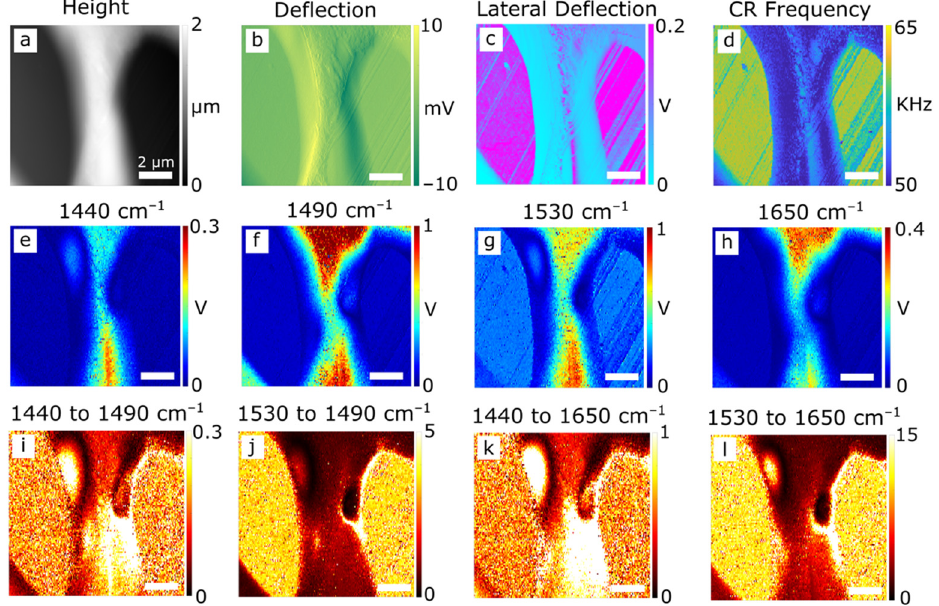
Figure 2. AFM-IR analysis of a PPB section showing 10 × 10 µ m maps of ( a ) height, ( b ) vertical deflection, ( c ) lateral deflection, ( d ) CR frequency of the cantilever, and IR intensities at ( e ) 1440, ( f ) 1490, ( g ) 1530, and ( h ) 1650 cm − 1 , corresponding to known resonances of PEEK (1490 and 1650 cm − 1 ) and PBI (1440 and 1530 cm − 1 ). Ratio maps for each pair of PEEK-PBI bands are shown in ( i – l ).